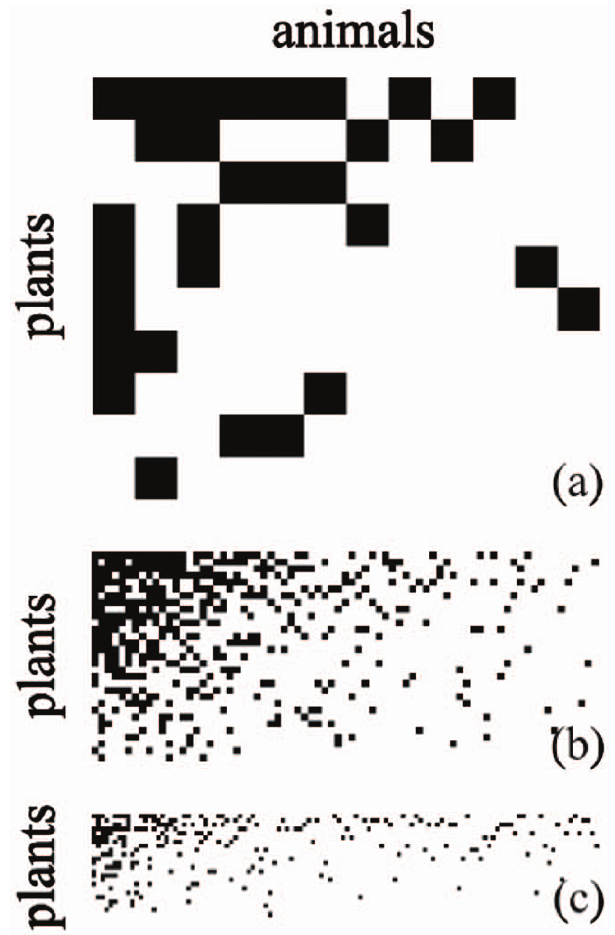
Figure 2. Interaction networks of mutualistic systems. Plants (rows) and animals (columns) are sorted from generalist to specialists (top to bottom and left to right respectively, as in Fig. 1). a) Flores Island (Azores archipelago), 10 | 12 , r ~ 0 : 25 , r ~{ 0 : 19 . b) Zackenberg station (Greenland), 31 | 75 , r ~ 0 : 18 , r ~{ 0 : 1 . c) Abisko (northern Sweden), 24 | 118 , r ~ 0 : 09 , r ~{ 0 : 20 . All three from [22].